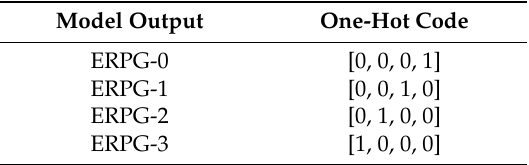
Table 2. Model output weight one-hot code table.